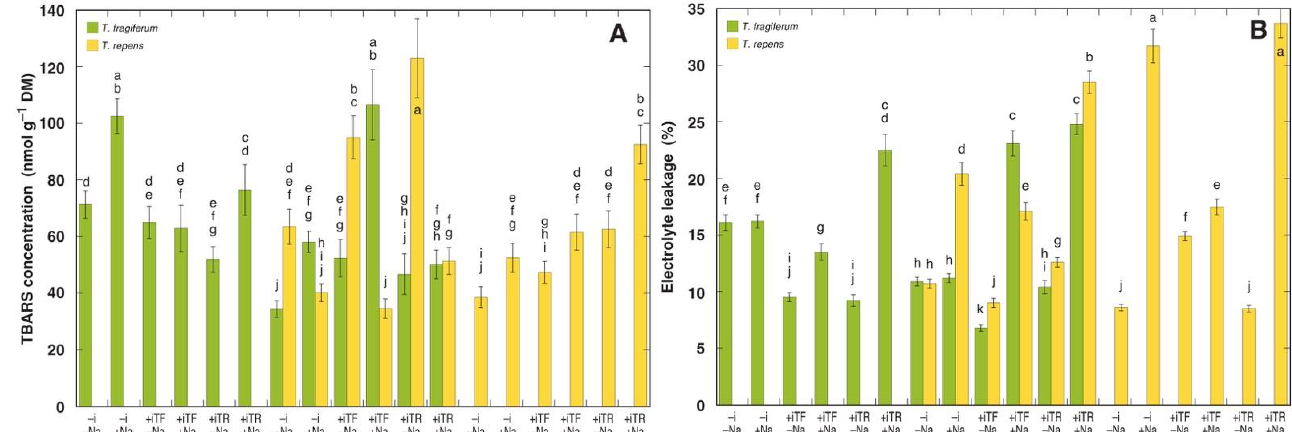
Figure 7. TBARS concentration in leaves ( A ) and electrolyte leakage ( B ) of T. fragiferum and T. repens at the harvest. Data are the means from three replicates ± SE, the results for TBARS are expressed on dry mass basis. −i, without inoculant; +iTF, with inoculant isolated from T. fragiferum ; +iTR, with inoculant isolated from T. repens ; − Na, no NaCl added; +Na, NaCl up to 400 mM. Different letters indicate significant differences between the treatments ( p < 0.05).